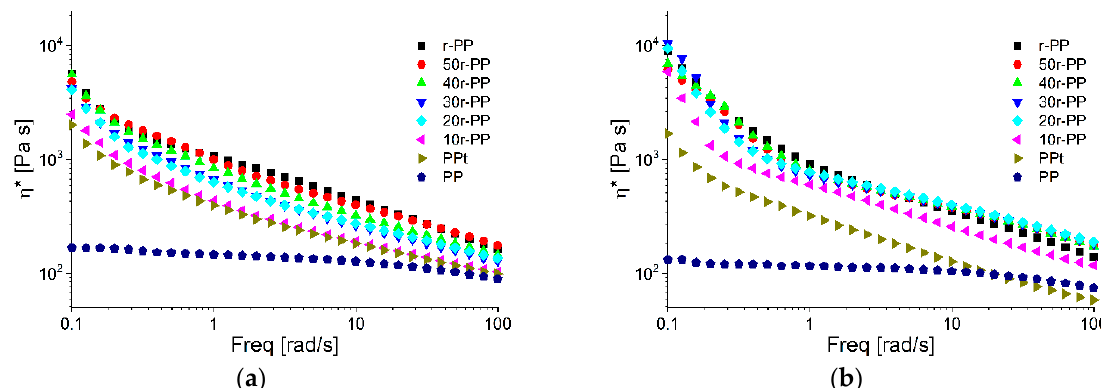
Figure 2. Complex viscosity curves measured at 230 ( a ) and 260 °C ( b ) for all the investigated mate-